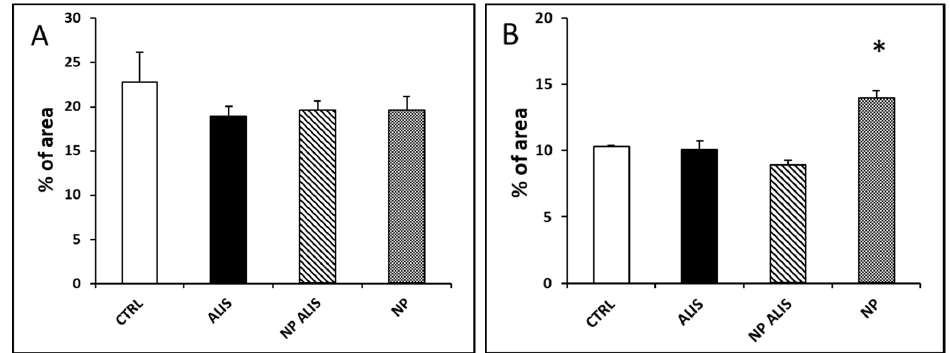
Figure 8. Effect of powdered aliskiren (ALIS), nanoparticle-loaded aliskiren (NP ALIS), and nanoparticles only (NP) on neuronal nitric oxide synthase (nNOS) protein expression in the left ventricle ( a ) and aorta ( b ). * p < 0.01 vs. CTRL; Values represent mean ± SEM of 6 animals.